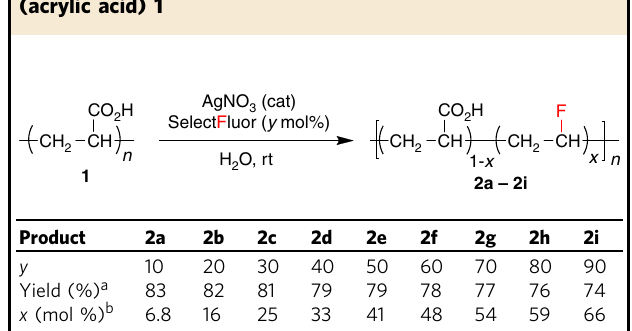
Table 1 Controlled decarboxylative fl uorination of